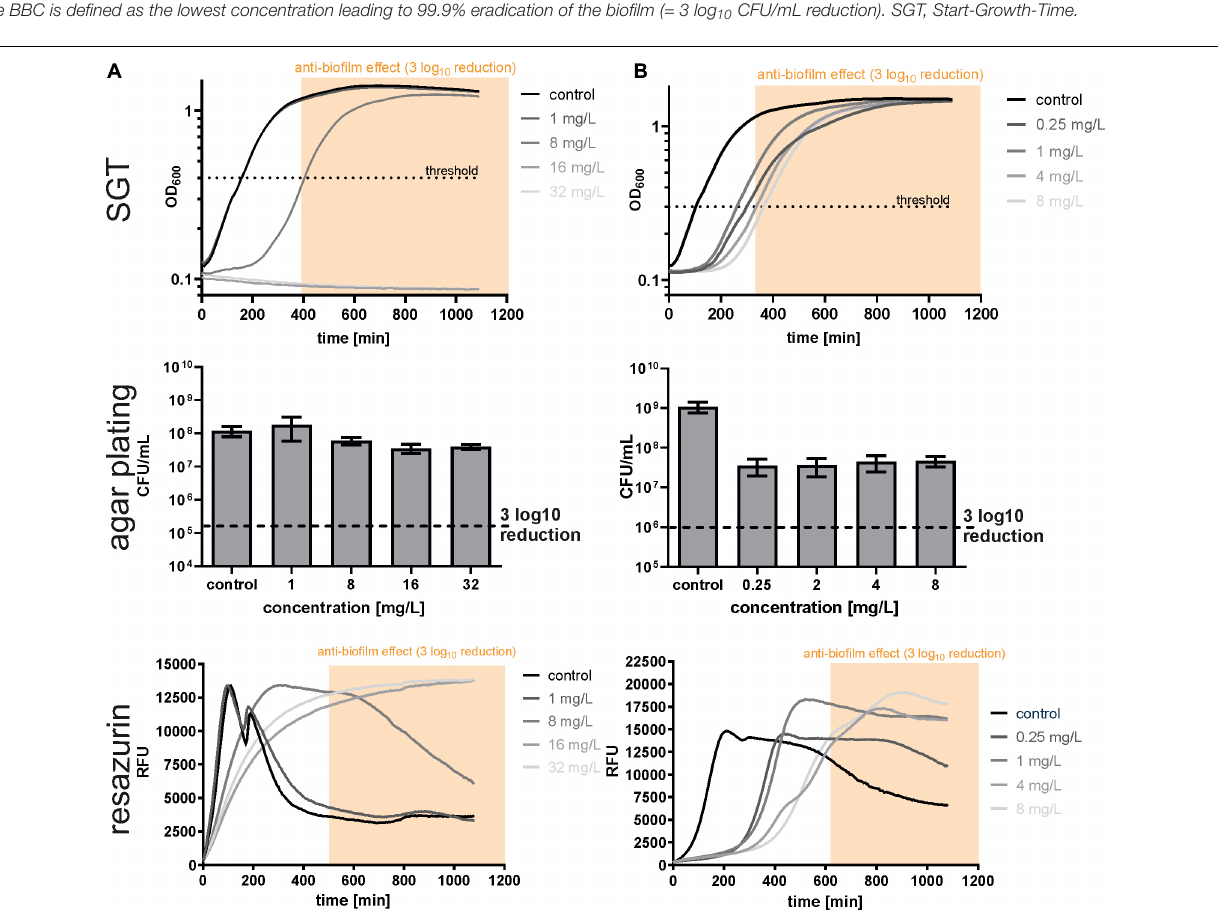
biofilms, have been treated and then were re-transferred into the planktonic phase for recording of the growth curves) versus non-biofilm, conventional planktonic cells treated with 20x